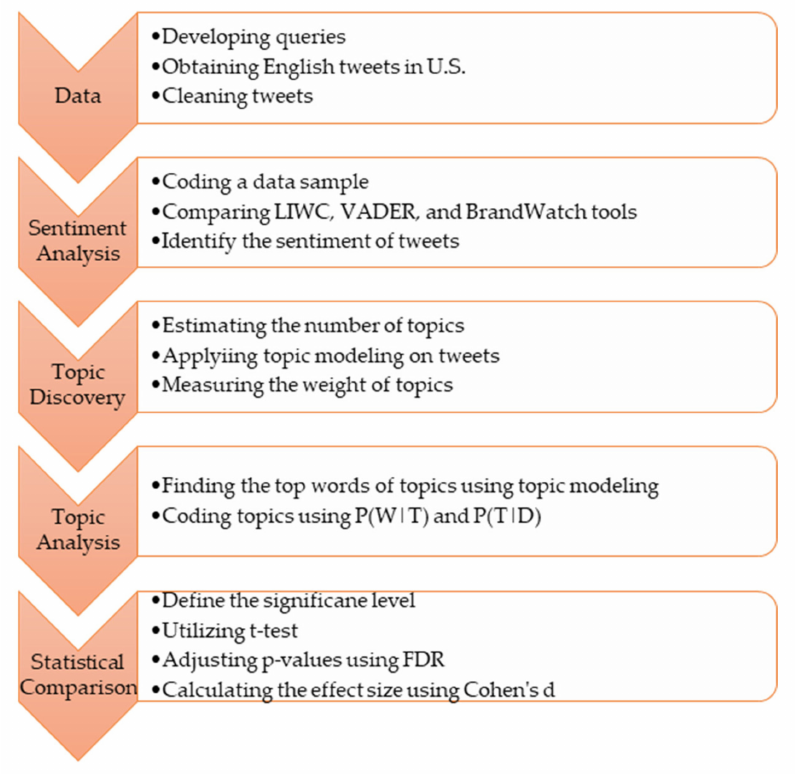
Figure 1. Research